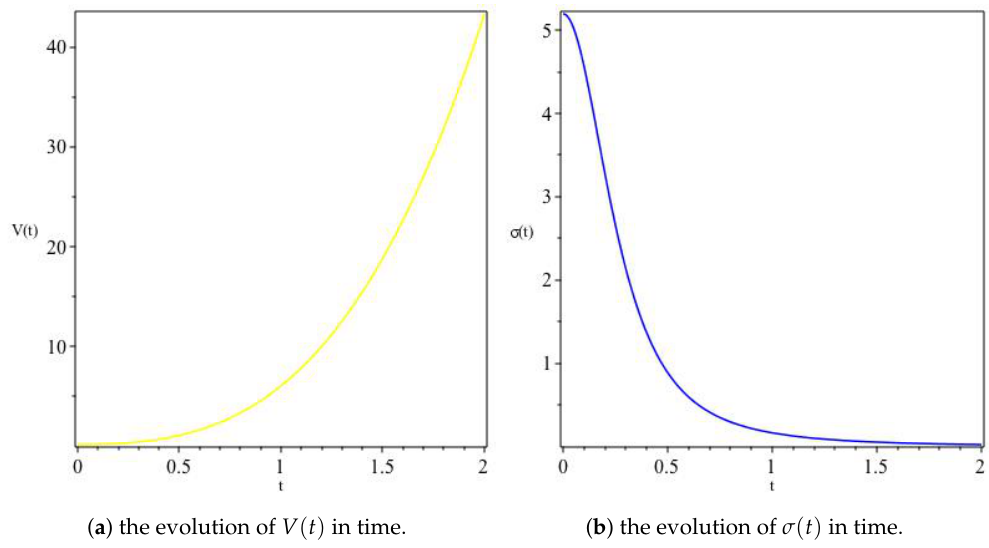
Figure 9. The variation of V and σ for Model I. Here as in Figures 2 and 5, albeit with different slopes, the left panel depicts a monotonically increasing volume of the the universe whereas the right panel depicts a universe isotropizing at late